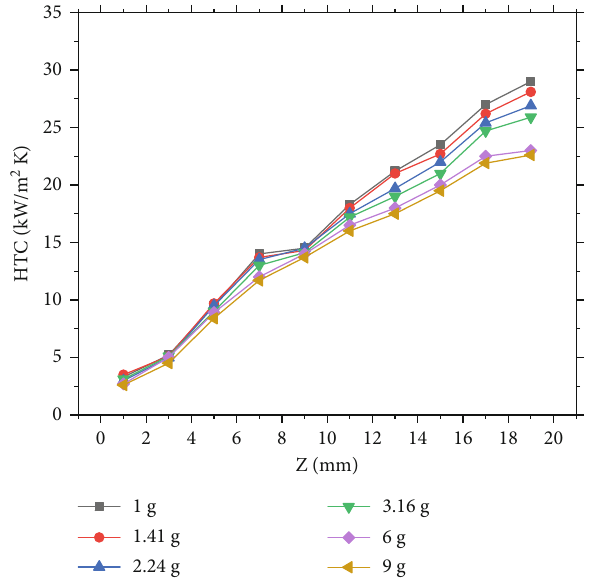
Figure 9: Heat transfer coe ffi cient of 0.05% nano fl uid under hypergravity.